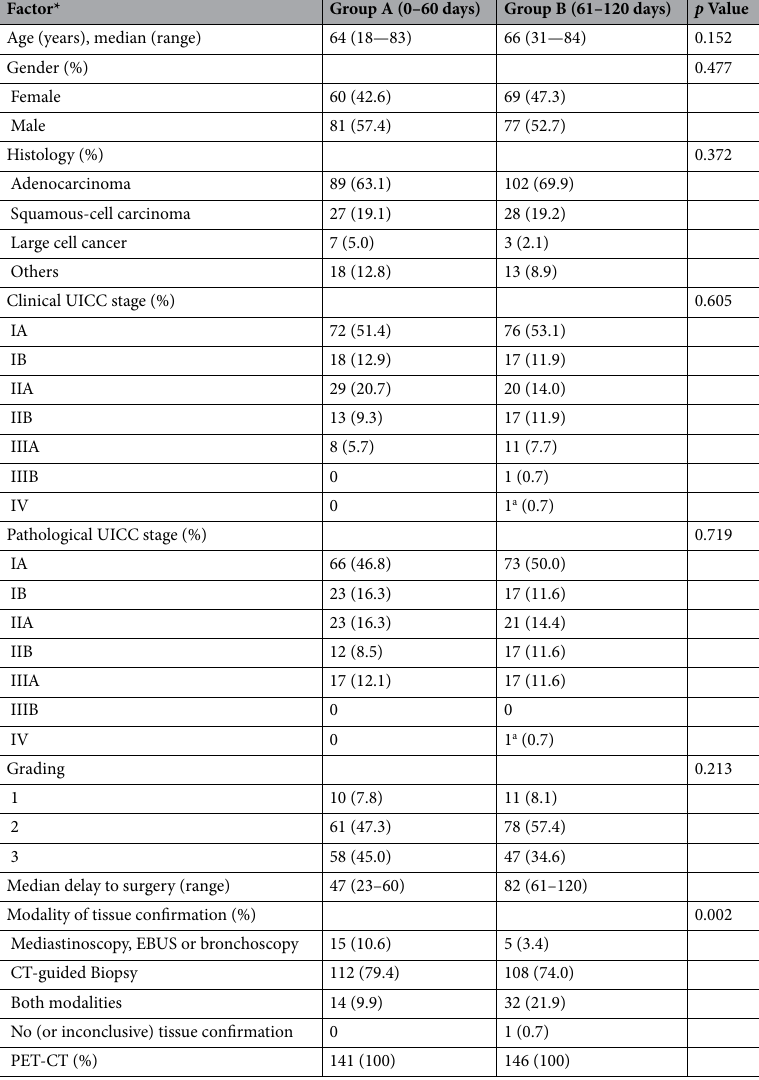
Table 1. Patients’ demographics. a 65-year old cT2bN0M1 patient with one PET-positive T11 vertebral metastasis. Tumour board decided for primary VATS resection and radiotherapy of the metastasis. *Some factors might not add up to 100% as data might have been inconclusive or not available (e.g. no grading in the pathological report, inconclusive preoperative staging, missing data from the primary care sector